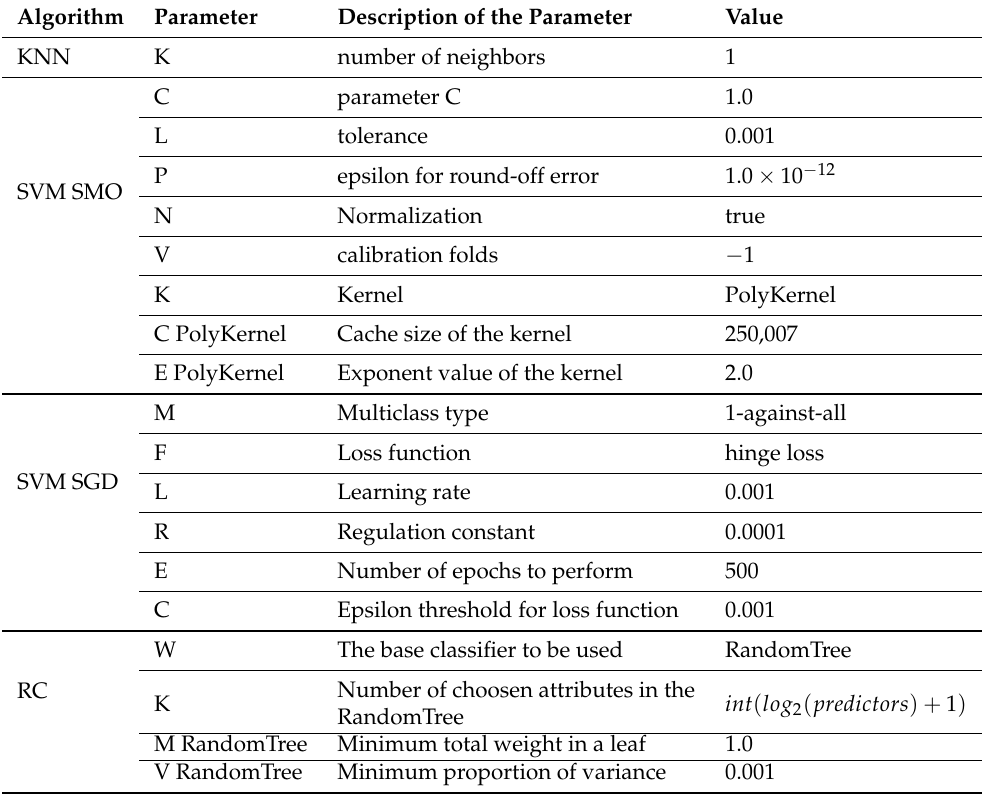
Table A1. Parameters of the